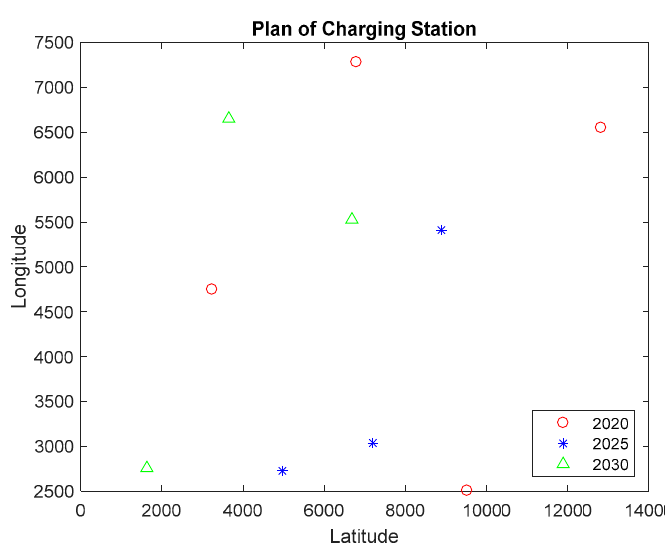
Figure 8. The optimal location of charging stations in 2020, 2025, and 2030.